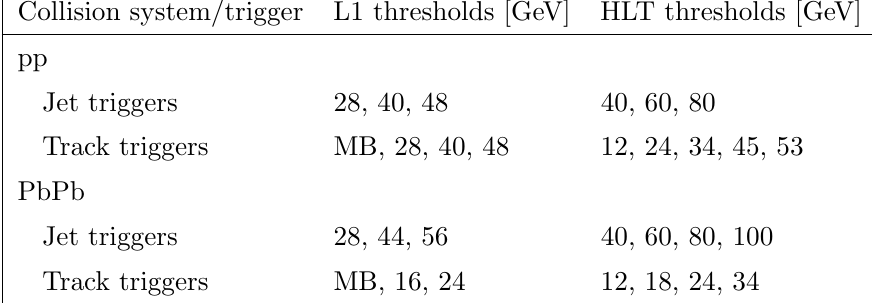
Table 2 . Summary of the E T and p T thresholds of the various L1 and HLT triggers used in the analysis for the two colliding systems. Please refer to the text about the exact meaning of the thresholds. Only the highest-threshold triggers collected data unprescaled. The MB symbol refers to seeding by a minimum-bias